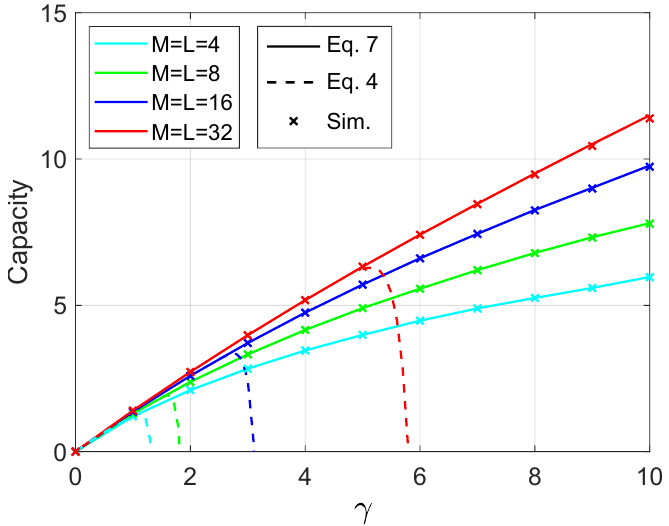
Figure 3. Analytical mean sum-rate capacity compared with